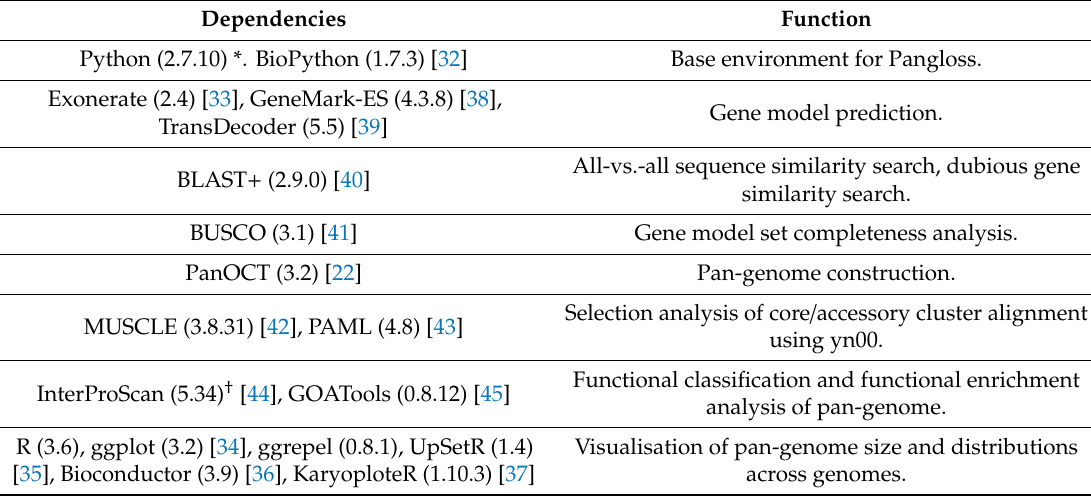
Table 1. List of various dependencies for Pangloss, versions tested in parentheses. PanOCT included with Pangloss. See http: // github.com / chmccarthy / Pangloss / for download location and detailed installation instructions for each dependency.